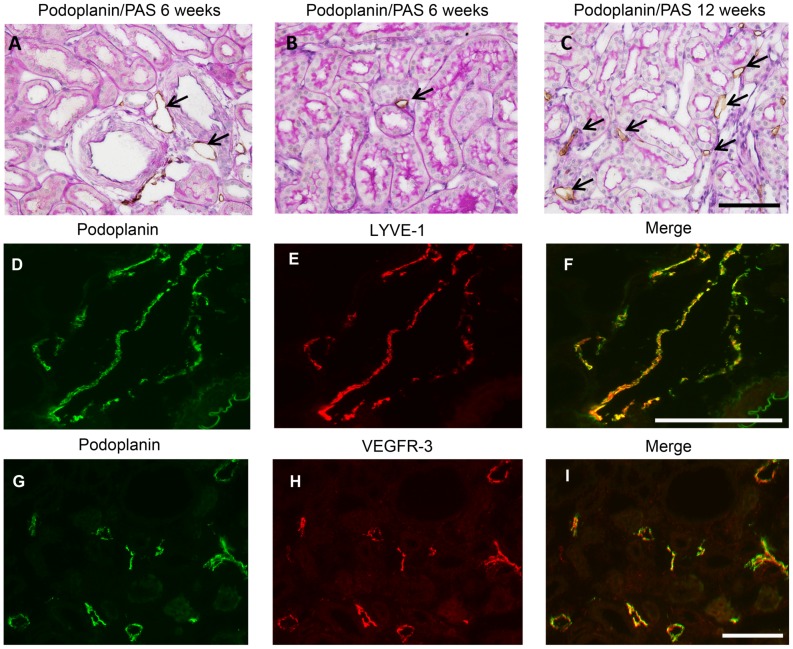
Identification of tubulo-interstitial lymph vessels.Podoplanin positive tubulo-interstitial vessel-like structures (indicated by black arrows) were present in the kidneys of saline-injected rats adjacent to large and middle-size arteries (A), and barely observed in cortical interstitial area, even in proteinuric kidneys at week 6 (B), however were clearly induced in the kidneys of adriamycin-injected rats at 12 weeks (C). Interstitial localization of these podoplanin-positive vessels becomes clear by the recognition of PAS-positive tubules. Double staining for podoplanin and LYVE-1 (D–F) and for podoplanin and VEGFR3 (G–I) confirmed interstitial podoplanin positive structures to be lymphatic endothelial cells, both in large and small lymphatic vessels. (Bar = 100 µm).